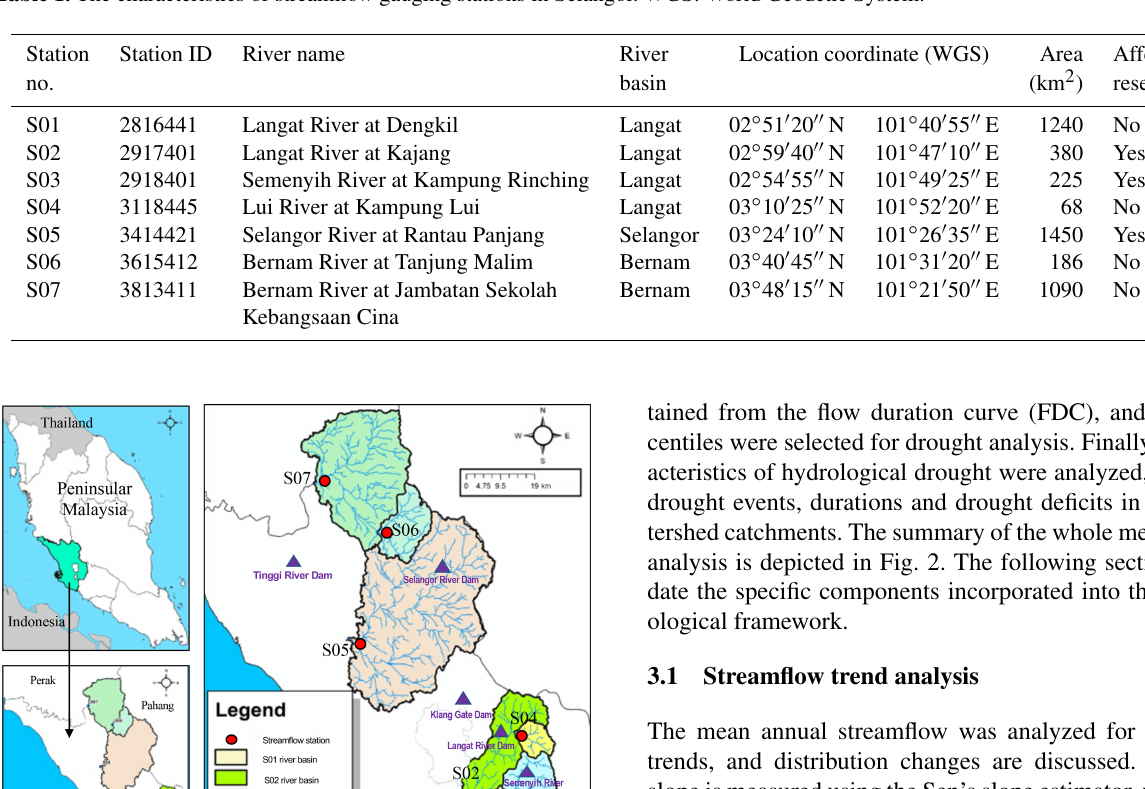
Table 1. The characteristics of streamflow gauging stations in Selangor. WGS: World Geodetic System.